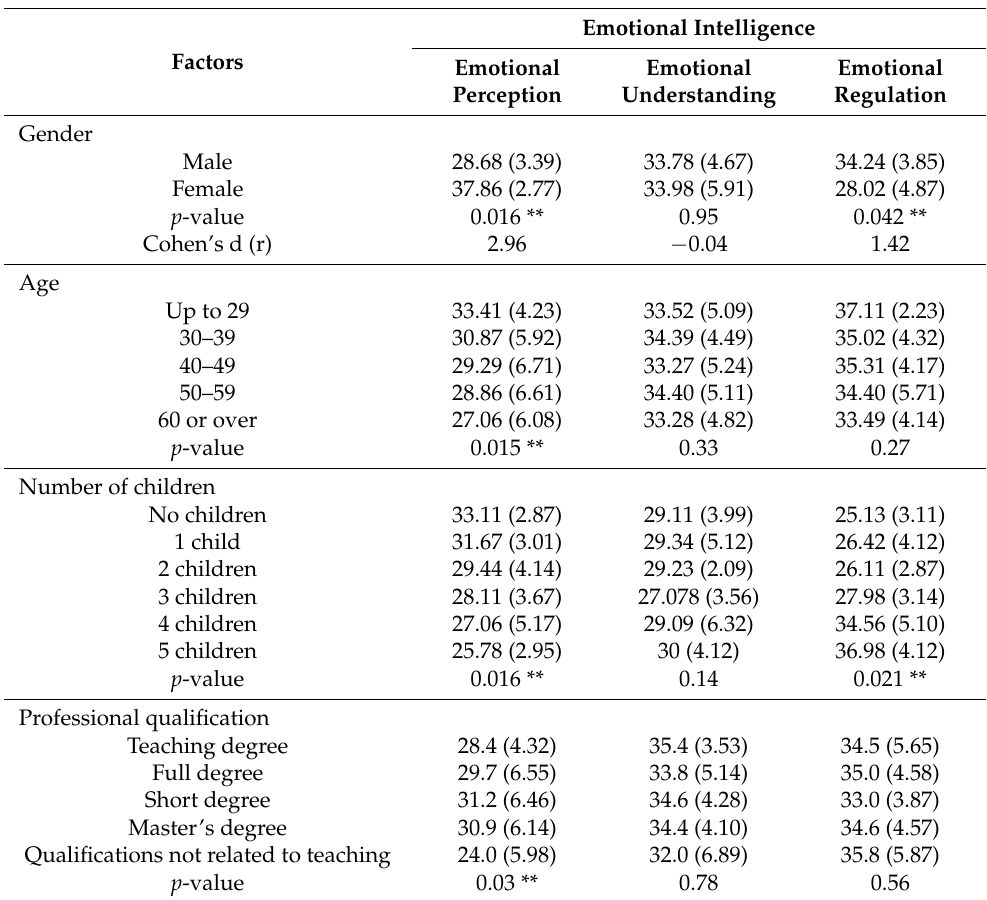
Table 5. Significant difference of the variables that make up the sociodemographic profile in emo- tional